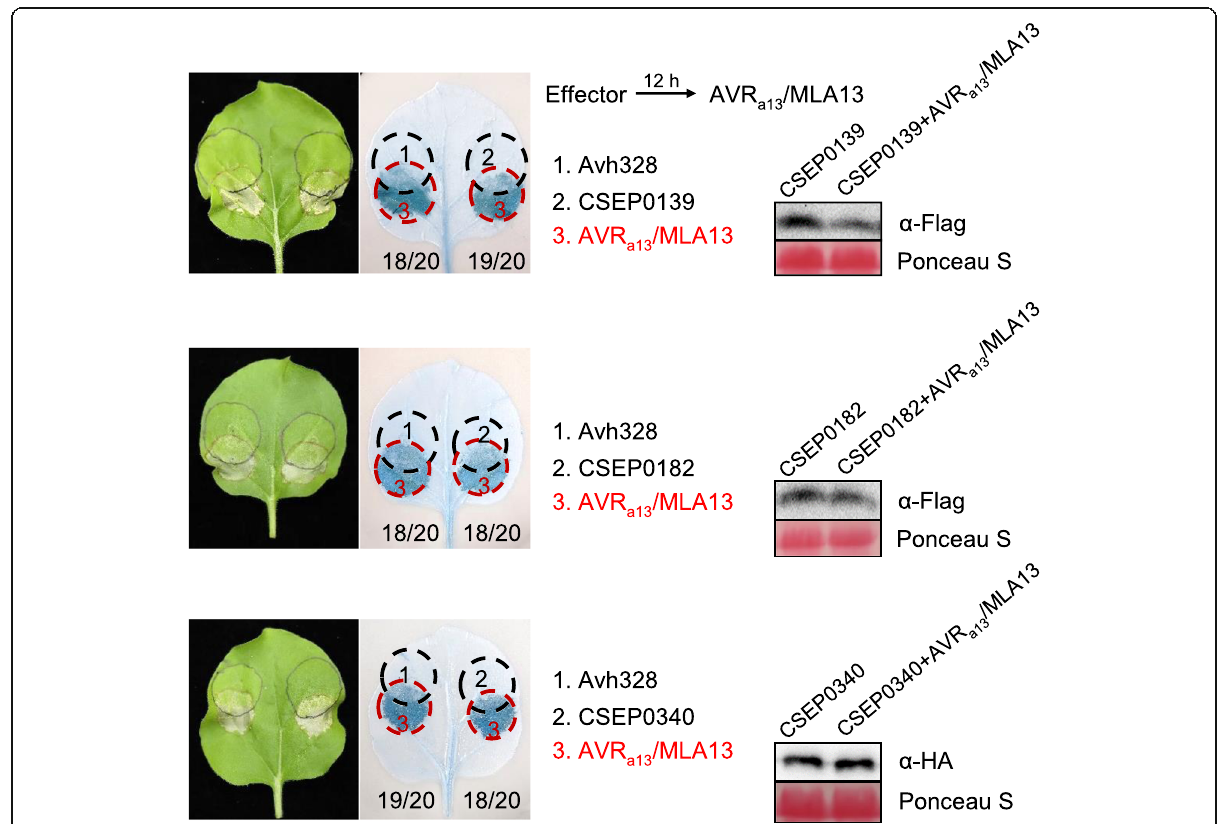
Fig. 3 CSEP0139 and CSEP0182 do not inhibit AVR a13 /MLA13-induced cell death in N. benthamiana . Oomycete Avh328 and CSEP0340 were used as a positive and a negative control, respectively. The experimental procedures are same as those in Fig. 2 except that the AVR a13 /MLA13 pair, instead of BAX or Nt MEK2 DD , was expressed 12 h after the expression of CSEP0139 or